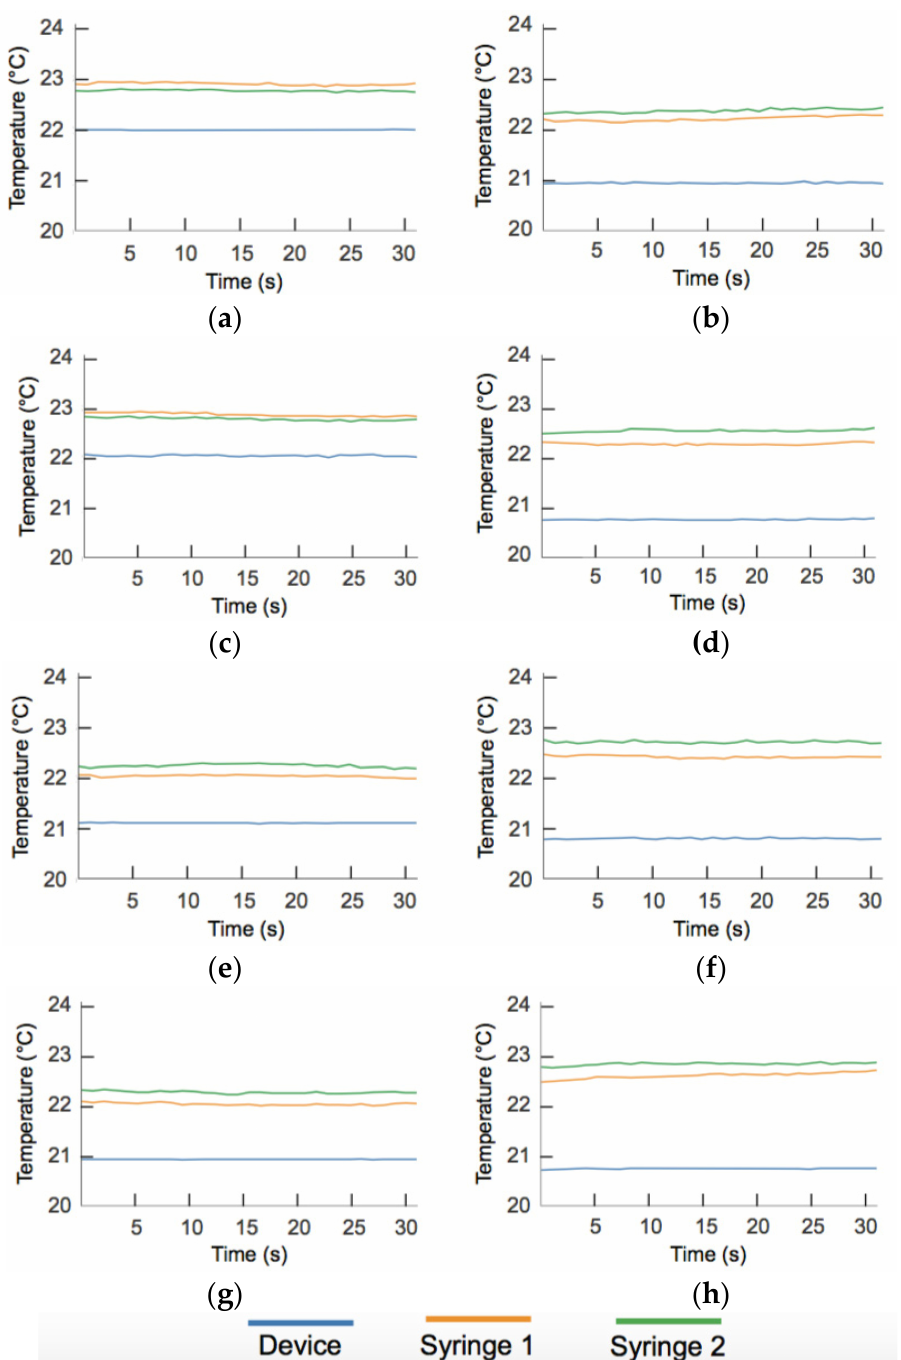
Figure A2. Temperature recordings over the steady state measurement period in the experiment described in Results and Discussion to measure device nonlinearity as a function of flow rate. See Section 4 for a detailed description of experimental protocol. ( a ) 0 mL/h; ( b ) 4 mL/h; ( c ) 1 mL/h; ( d ) 5 mL/h; ( e ) 2 mL/h; ( f ) 7 mL/h; ( g ) 3 mL/h; ( h ) 9